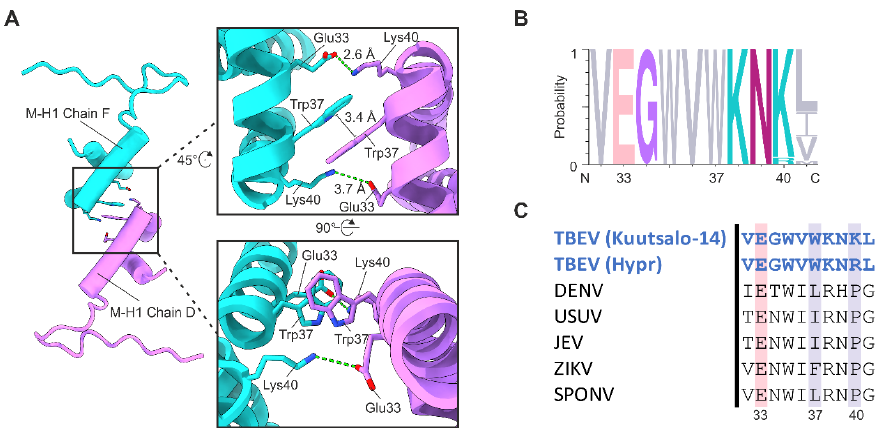
Figure 3. Interactions at the M heterotetramer interface. ( A ) Interaction between the two tilted M proteins located at the heterotetramer interface. Chain D is shown in purple and chain F shown in turquoise. Interacting residues are shown as stick representations and labelled in the close-up views (right). Hydrogen bonds are shown by green dotted lines. The distance between the interacting residues is labelled. ( B ) Sequence conservation of the interacting M residues in 183 TBEV isolates. The consensus residues are shown with the size of the letter proportional to the frequency of the residue. Interacting residues are marked with numbers and the residues are coloured according to chemistry (grey, hydrophobic; pink, acidic; purple, polar including glycine; turquoise, basic; magenta, neutral). ( C ) Structure-based sequence alignment of flaviviruses. Positions conserved throughout flaviviruses are highlighted in pink, and positions conserved only in the majority of TBEV strains are highlighted in grey. The interacting residues are numbered according to TBEV Kuutsalo-14 sequence (GenBank: